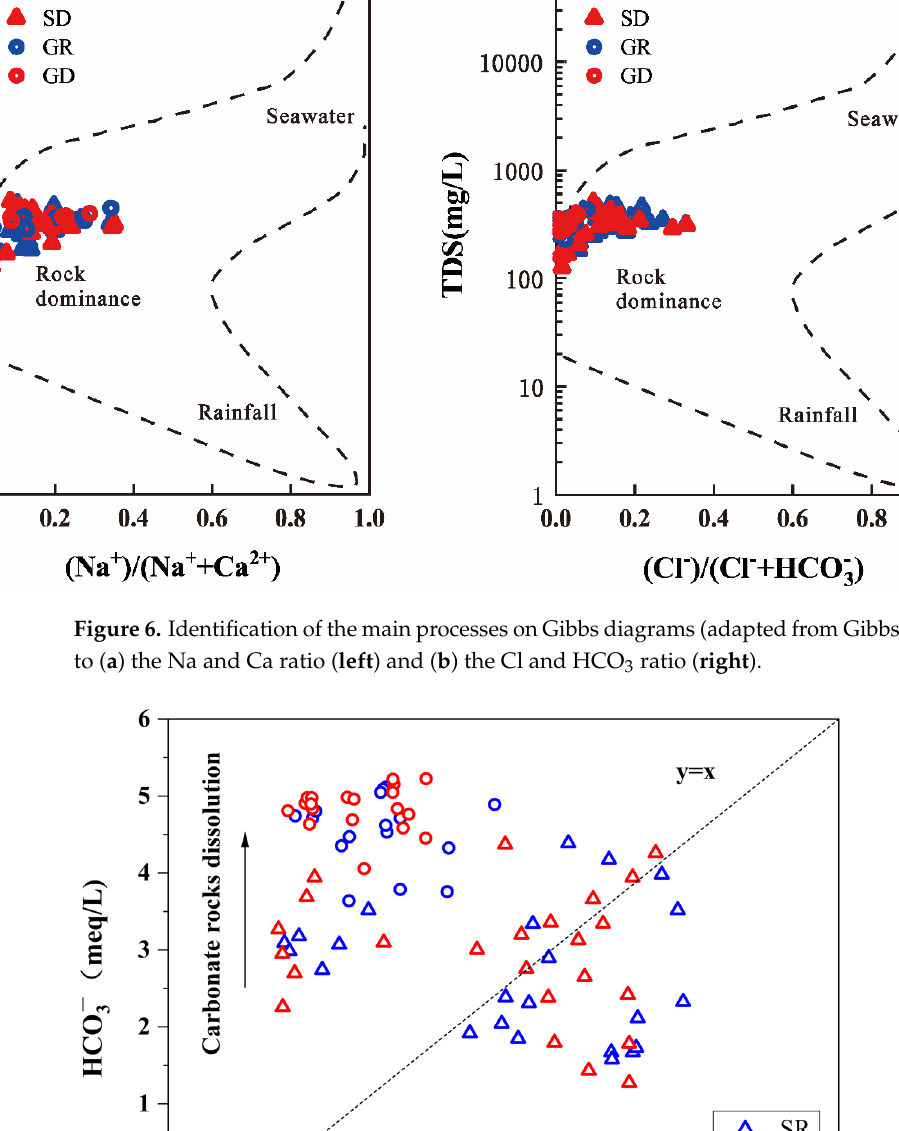
. Figure 7. Relationship between (SO 2 − 4 + Cl − ) and HCO − 3 3